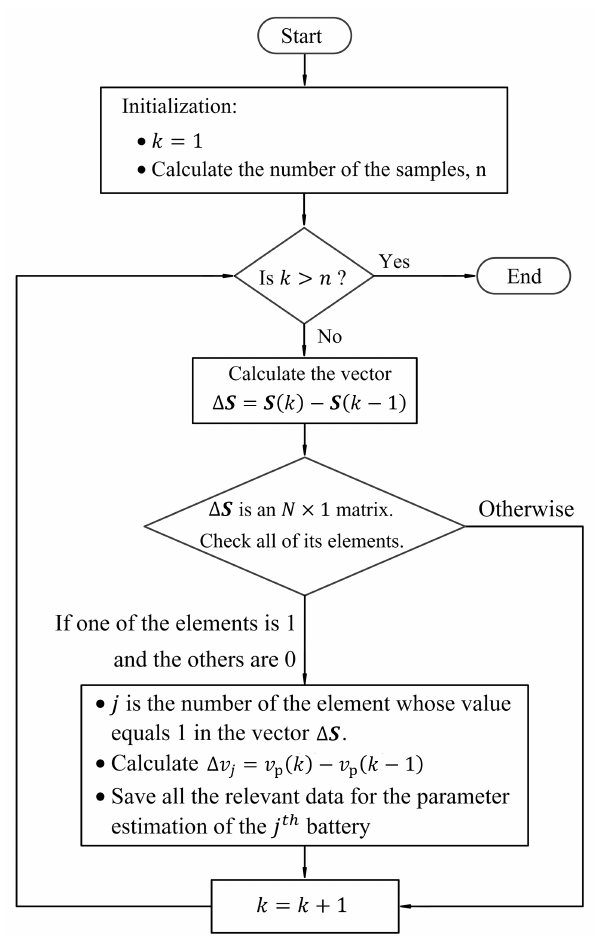
Figure 4. Flowchart of the decoupling